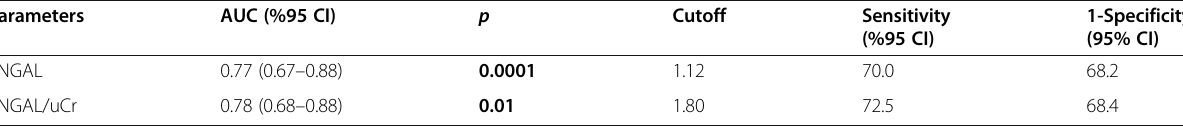
Table 2 The cut off, area under the curve (AUC), sensitivity and 1-specificity of uNGAL in patients with familial Mediterranean fever Parameters